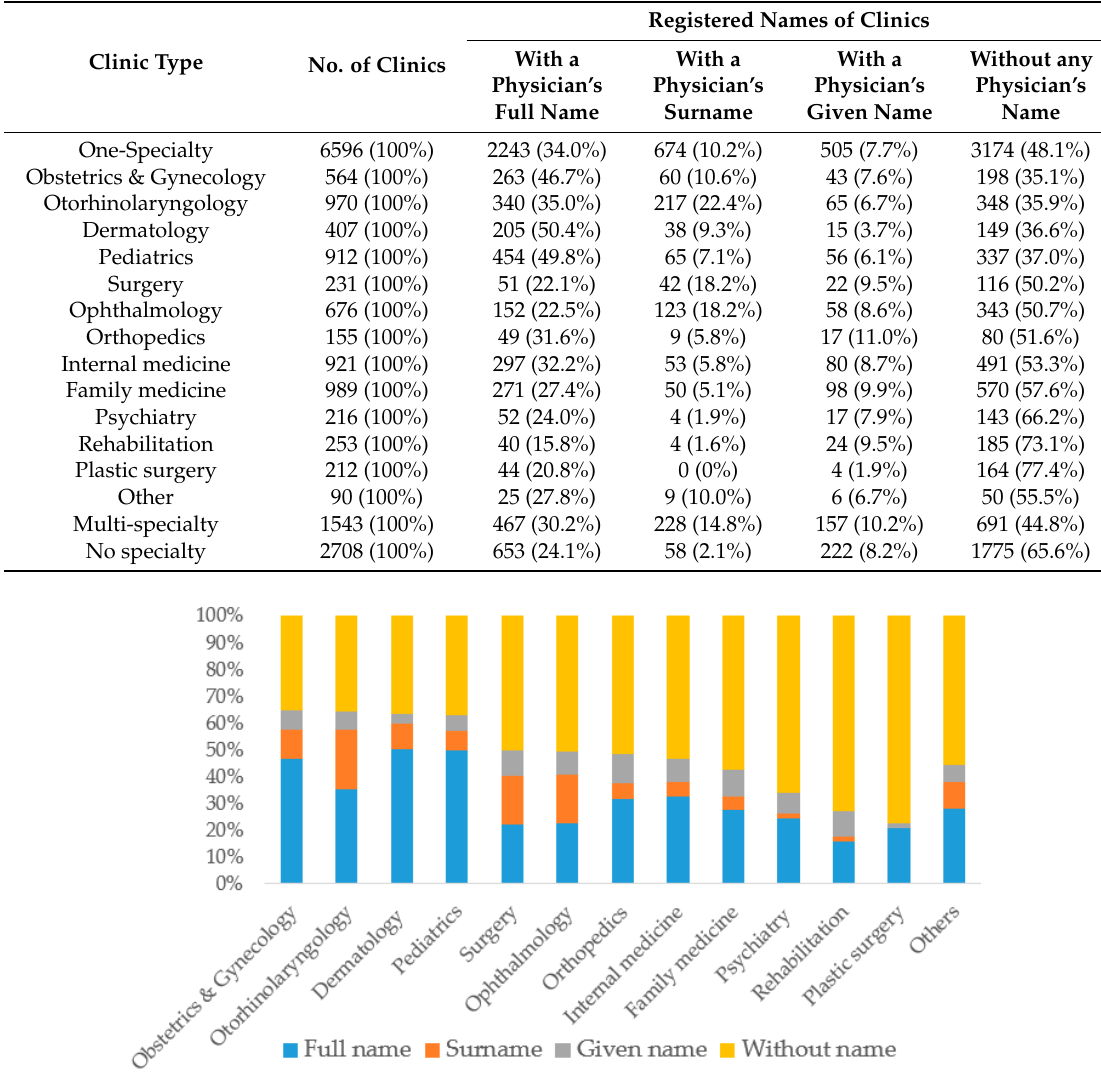
Table 2. Registered names in clinics with different specialties in Taiwan.